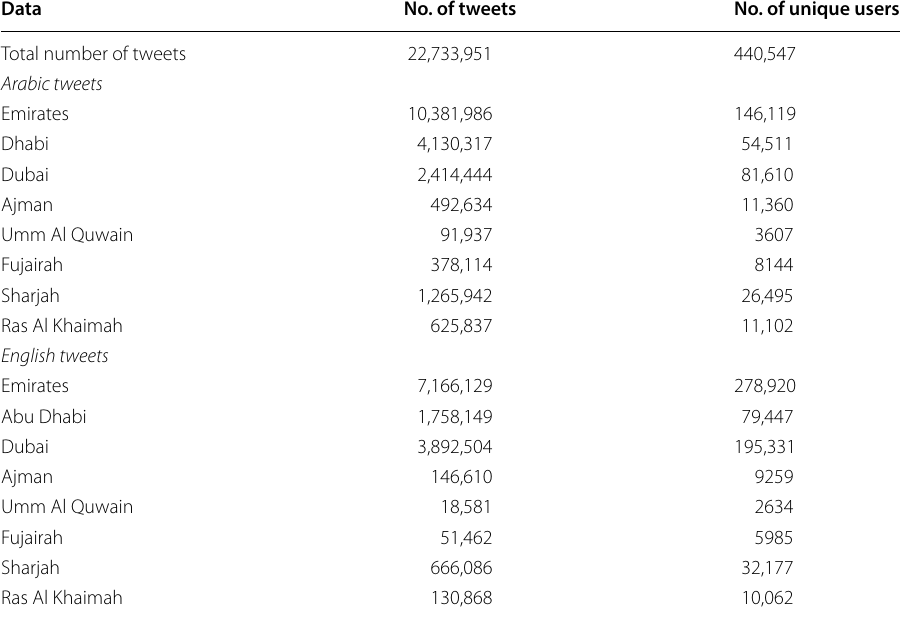
Table 1 General information of the dataset Data No. of